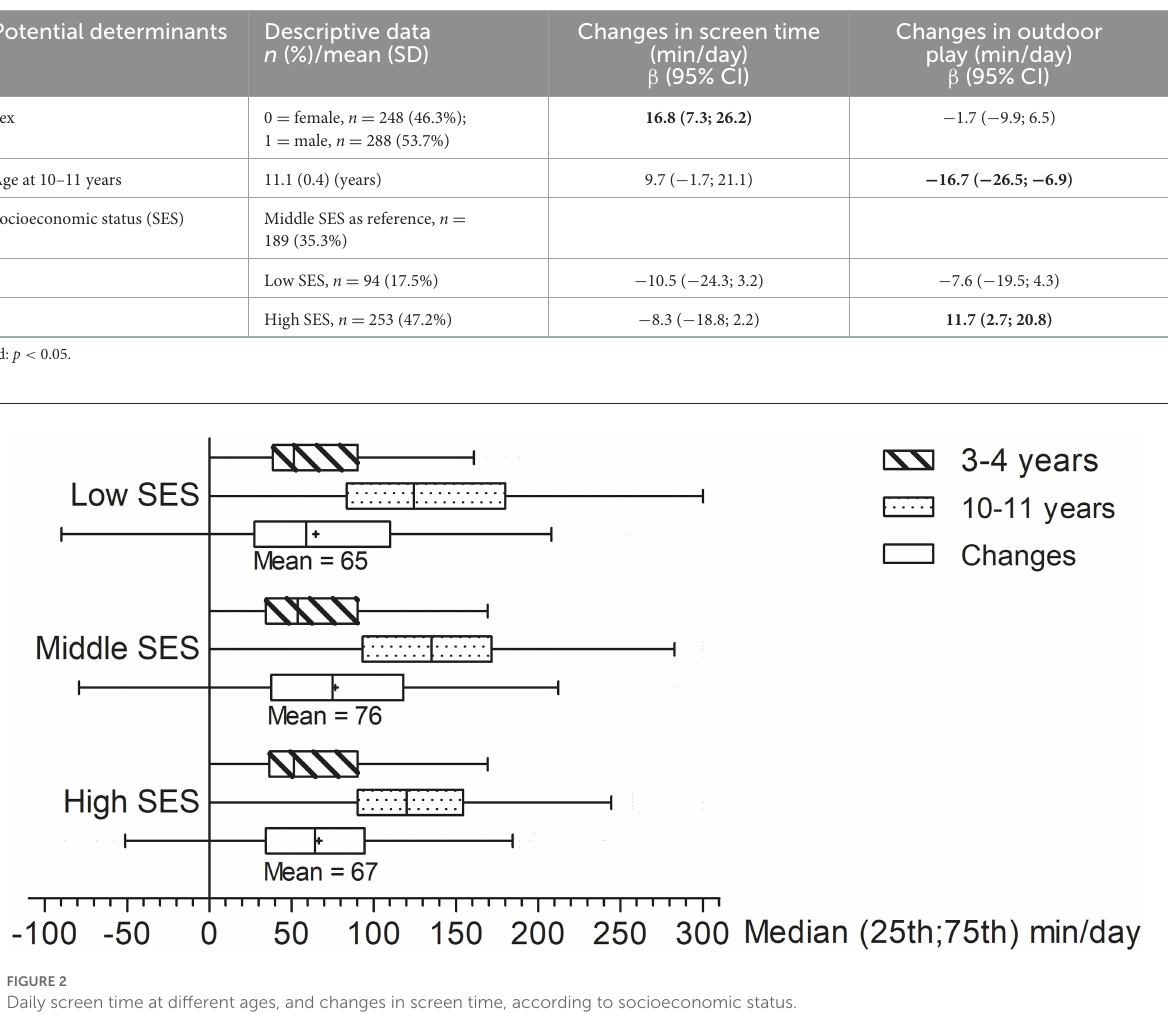
TABLE 3 Socioeconomic status and changes in children’s screen time and outdoor play from 3–4 to 10–11 years.